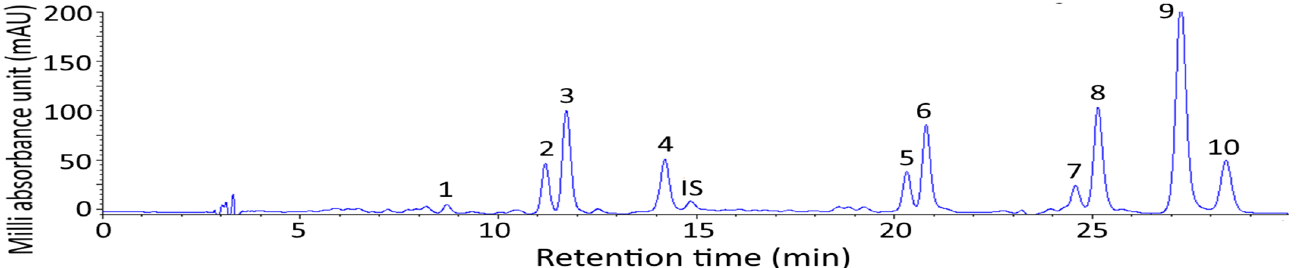
Figure 1. HPLC chromatogram of carotenoids extracted from sweet potato peel (TNG66). Column, C30; gradient mobile phase of methanol-acetonitrile-water (74:14:12, v/v/v ), and dichloromethane (100%); flow rate, 1 mL/min; detection wavelength, 450 nm. Peaks: 1–All-trans-violaxanthin, 2–cis-lutein, 3–All-trans-lutein, 4–All-trans-zeaxanthin, IS–All-trans-canthaxanthin, 5–15- or 15 ′ -cis- β -cryptoxanthin, 6–All-trans- β -cryptoxanthin, 7–15- or 15 ′ -cis- β -carotene, 8–13- or 13 ′ -cis- β -carotene, 9–All-trans- β -carotene, 10–All-trans- α -carotene. For method validation and quantitation, the standard curves of all-trans forms of lutein, zeaxanthin, β -cryptoxanthin, β -carotene and α -carotene were prepared with the linear regression equations being y = 0.8493x − 0.0538, y = 0.8295x − 0.065, y = 3.5643x − 0.1506, y = 4.2761x + 0.3222 and y = 2.2856x − 0.2224, respectively, and the coefficient of determi- nation (R 2 ) all being higher than 0.99. The LOD of all-trans forms of lutein, zeaxanthin, β -cryptoxanthin, β -carotene and α -carotene was 0.1, 0.1, 0.025, 0.05 and 0.05 μ g/mL, respec- tively, while the LOQ was 0.3, 0.3, 0.075, 0.15 and 0.15 μ g/mL.